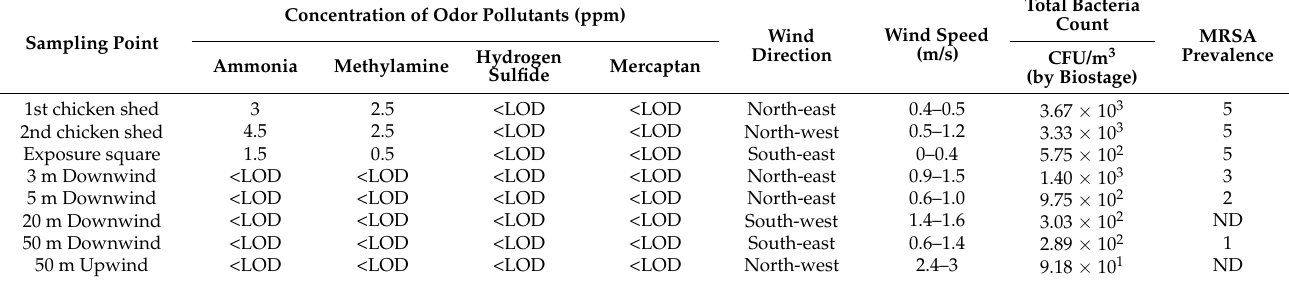
Table 1. The concentration of odor-producing compounds and the total airborne bacteria in the ambient